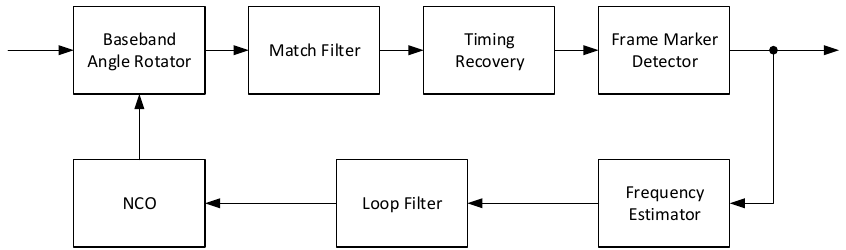
Figure 4. Single loopback frequency estimation